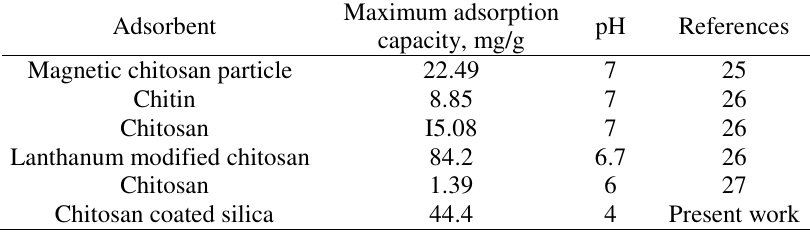
Table 2. Maximum adsorption capacity (mg/g) of different chitosan based adsorbents for